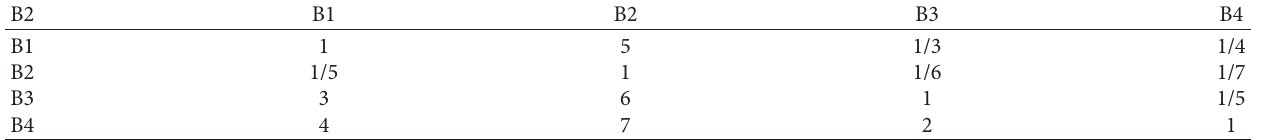
Table 11: The judgment matrix of major criteria with respect to information level (B2).